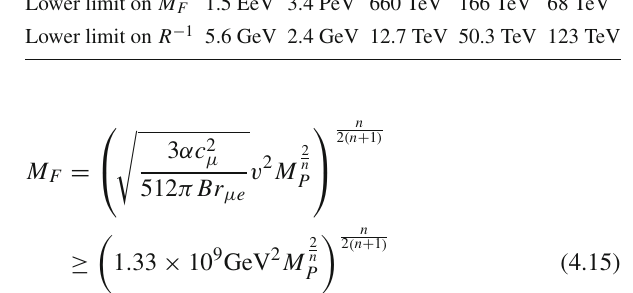
Table 5 Lower Limits for the fundamental scale of gravity M F for different number of extra dimensions n n . The 2